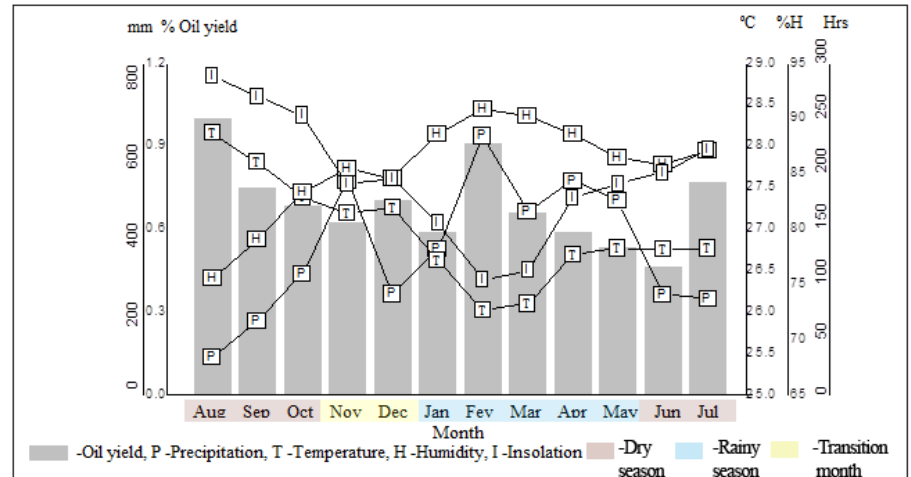
Figure 1. Environmental conditions vs. Eugenia patrisii essential oil yield in the seasonal study.